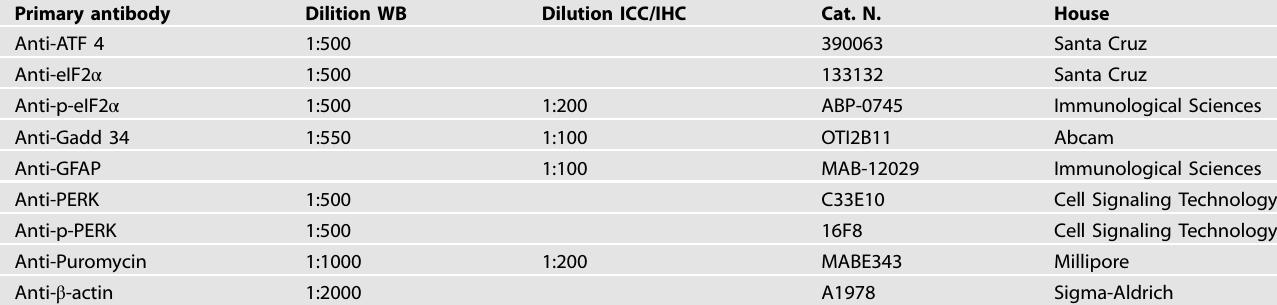
Table. 1. List of primary